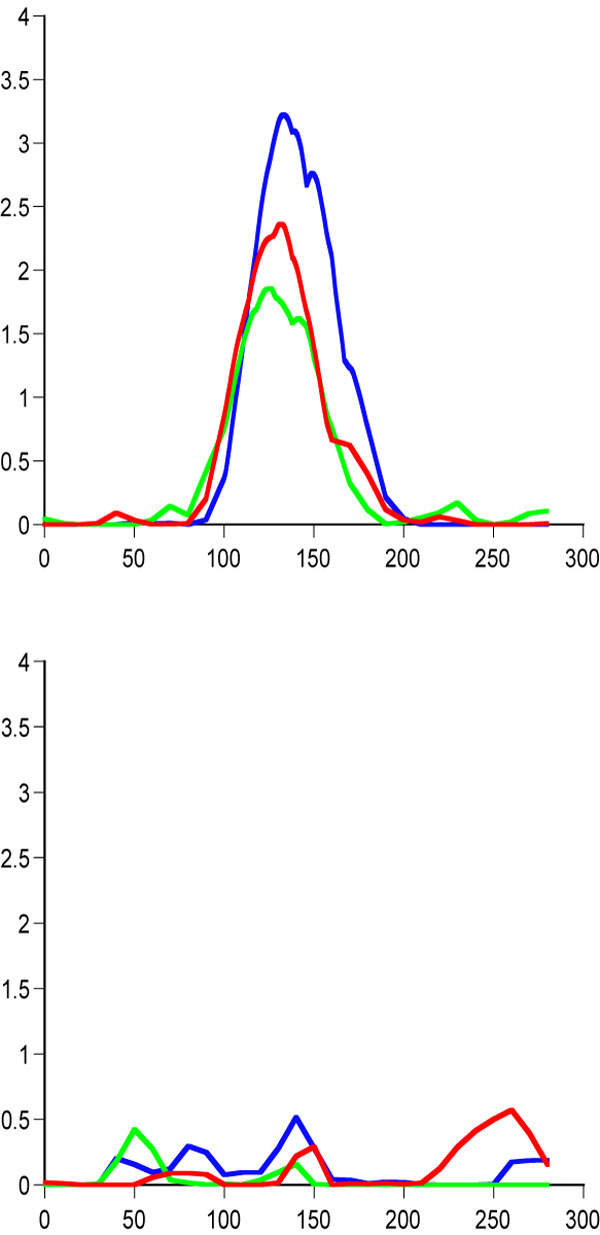
Genome-wide LOD score plots for HDL-C on chromosome 2 in females (left) and males (right) across all time points, t1 (blue), t2 (green), and t3